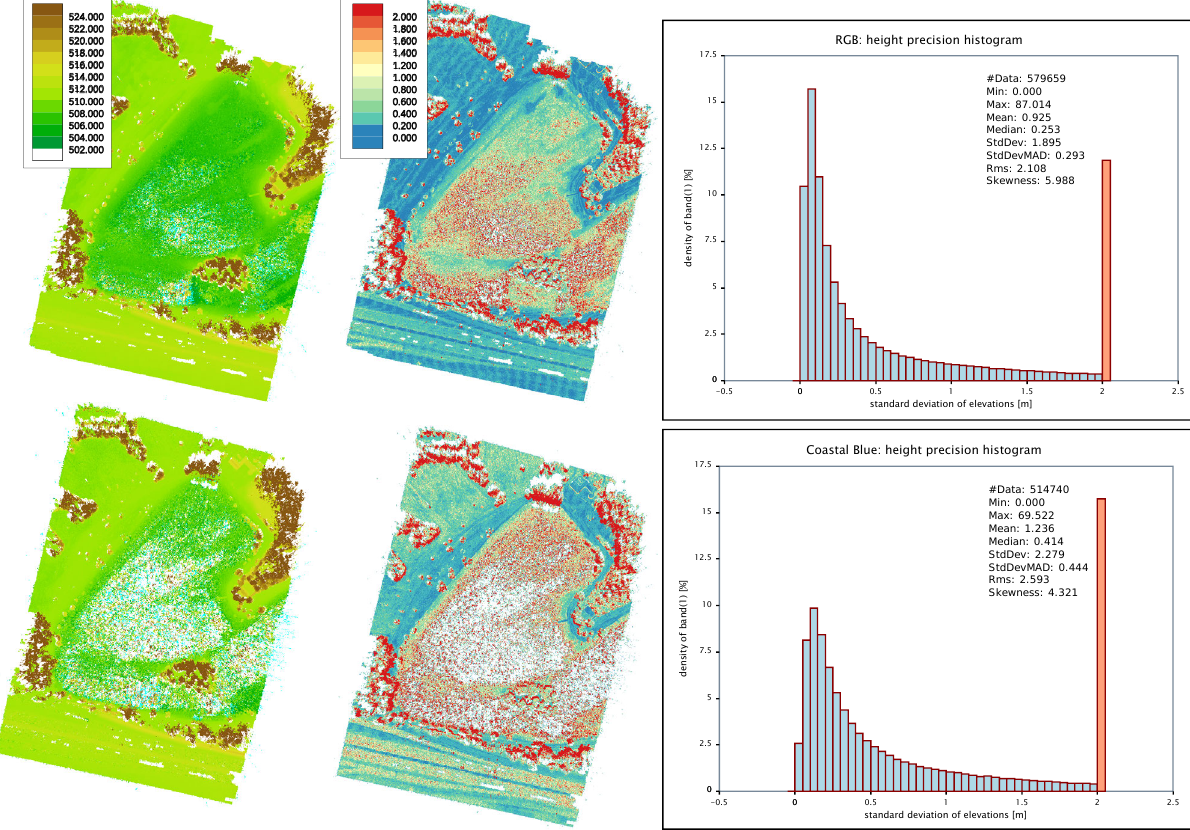
Figure 11. Results of Through-Water Dense Image Matching for stereo pair 52920-52921 based on RGB (top) and Coastal Blue (bottom) images; left: Color coded map of elevations [m]; middle: height precision [m]; right: height precision